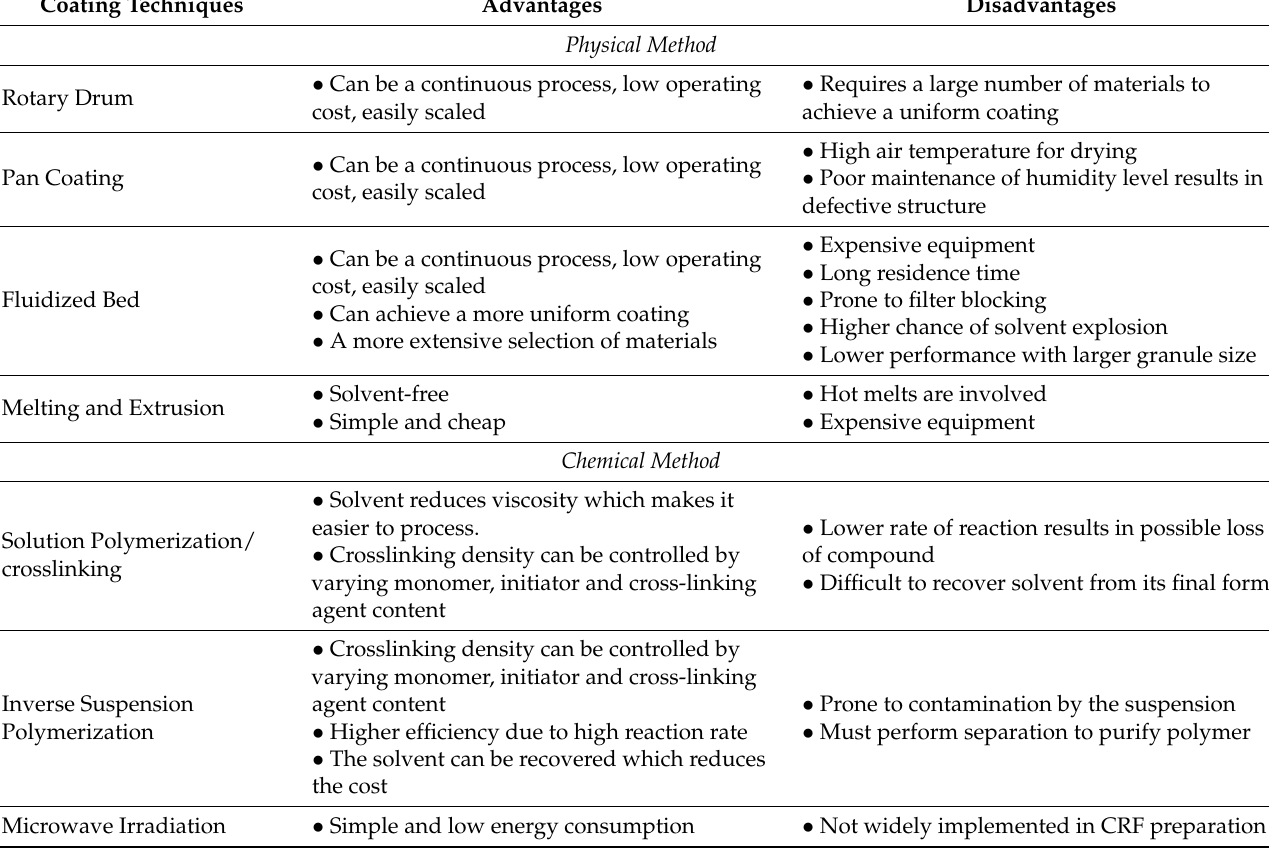
Table 5. Summary of coating